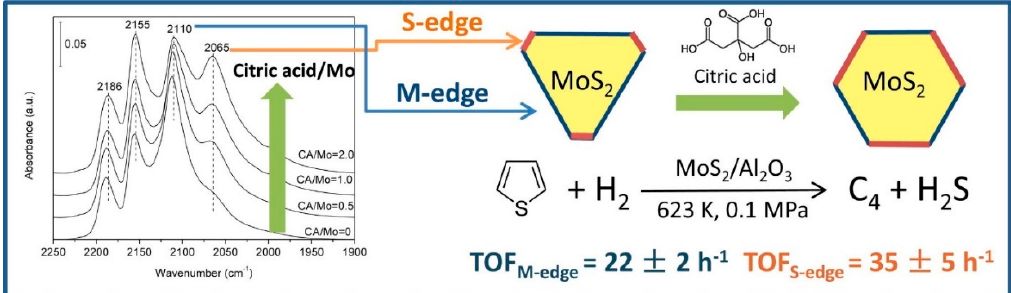
Figure 5. Effect of citric acid in slabs morphology, J. Chen et al. [94]. Figure 5. E ff ect of citric acid in slabs morphology, J. Chen et al.